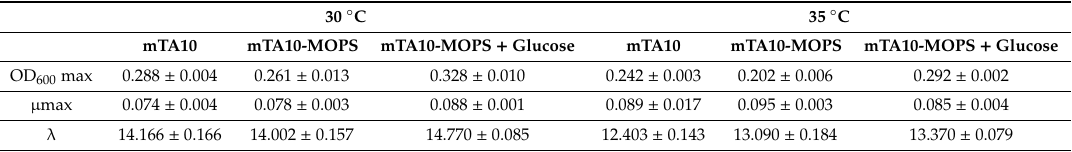
Table 3. Evaluation of the L. monocytogenes kinetic growth in different medium formulations. 30 ◦